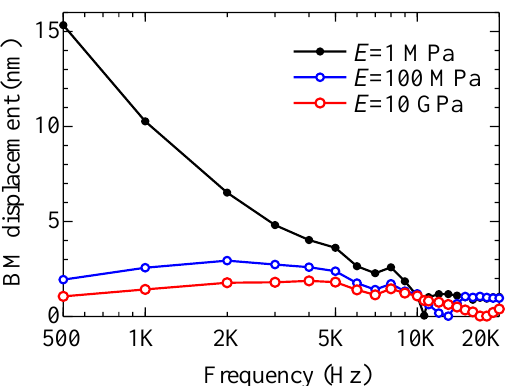
Figure 9. Frequency response of the maximum displacement of the basilar membrane when a sinusoidal plane wave with a pressure level of 1 Pa was excited at the oval window. Displacements of the basilar membrane for a healthy ear ( E = 1 MPa, in black), an ear with mild round window atresia ( E = 100 MPa, in blue), and an ear with severe round window atresia ( E = 10 GPa, in red) are presented, where E stands for the Young’s modulus of the round window membrane.